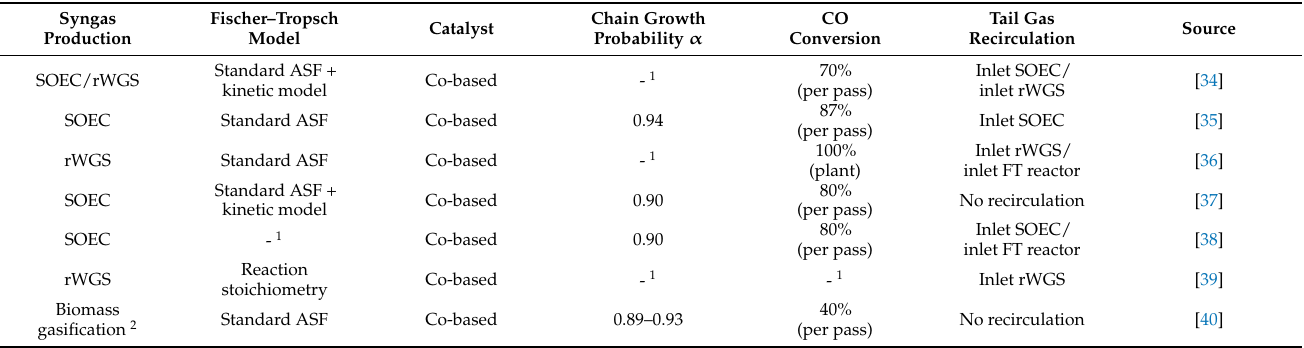
Table 2. Overview of previous works on the simulation of Power-to-Liquid plants based on Fischer– Tropsch